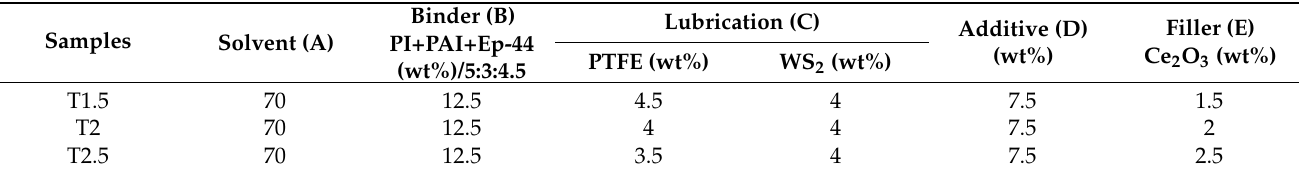
Table 1. Compositions and contents of three coatings.